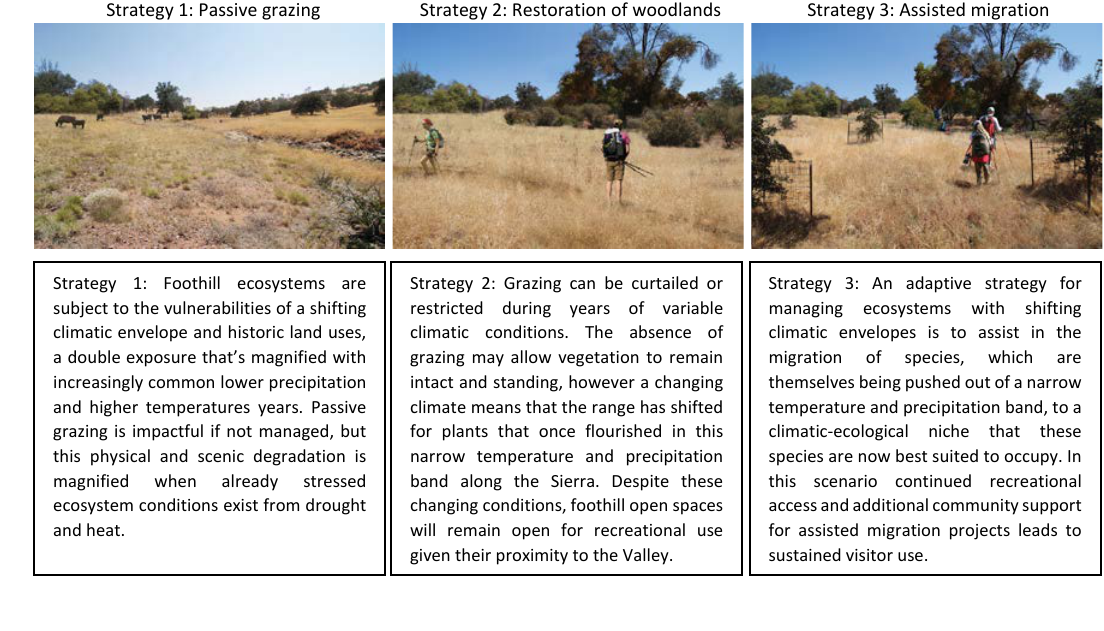
Strategy 1: Passive grazing